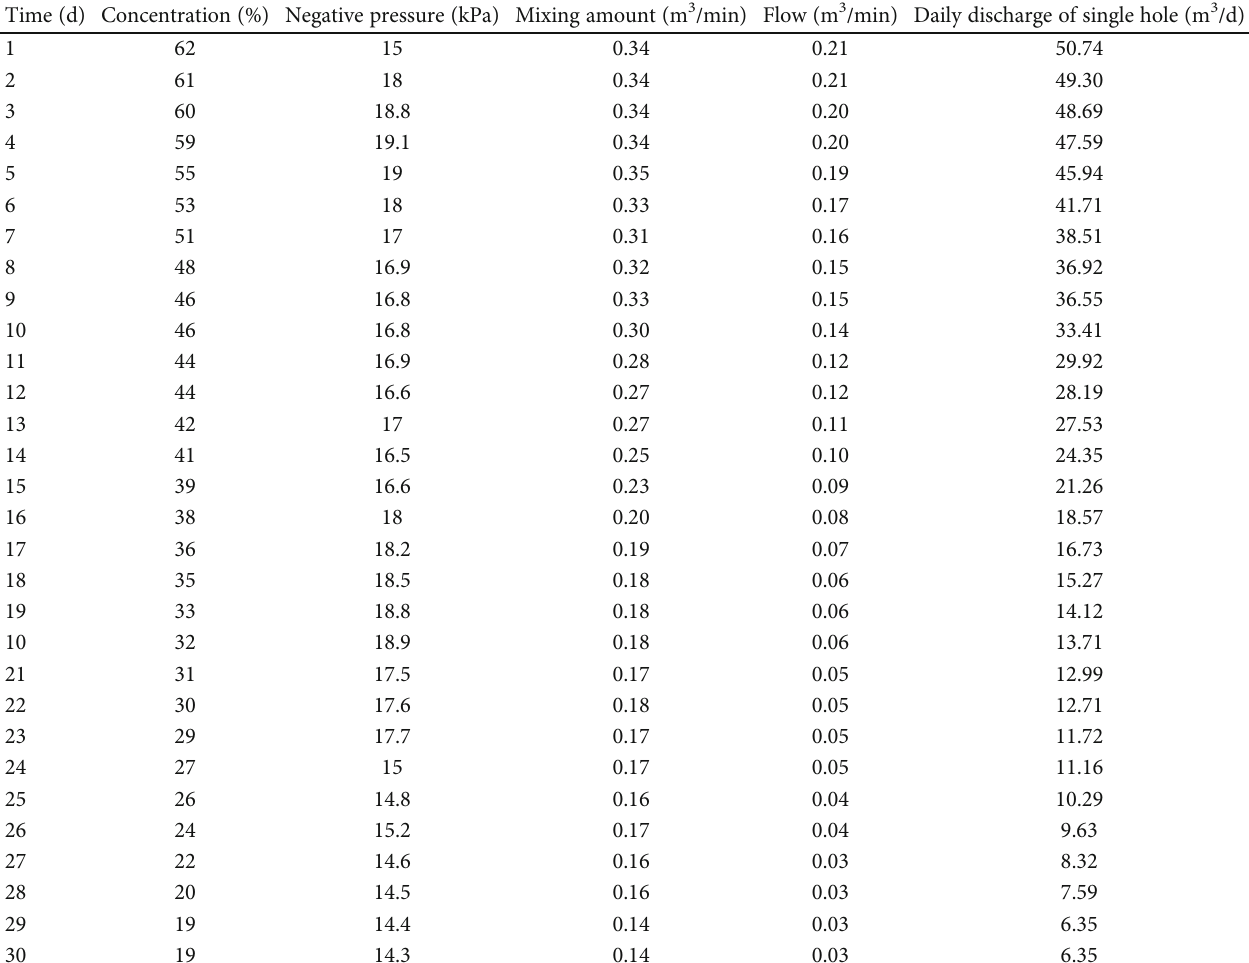
Figure 9: Change trend graph of gas drainage concentration and cumulative gas drainage scalar over time for the entire group of reaming holes K1 ~ K6 for 30 consecutive days. Table 3: Investigation table of unreamed conventional borehole drainage